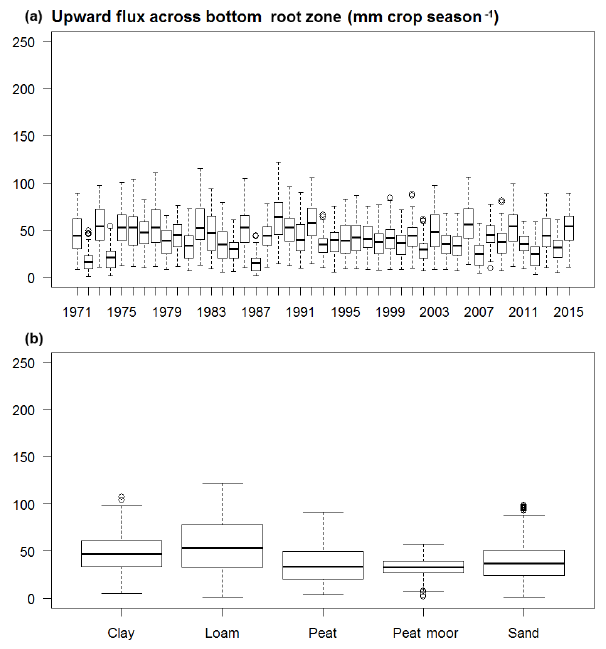
Figure 7. Results of the soil–crop experiment for potato: up- ward flux across the bottom of the root zone ( q caprise in mmcropseason − 1 ) for hydrological conditions with average groundwater level (Ave): (a) for results for all 72 soils for the period 1971–2015; (b) for results as box plots for clustered soil